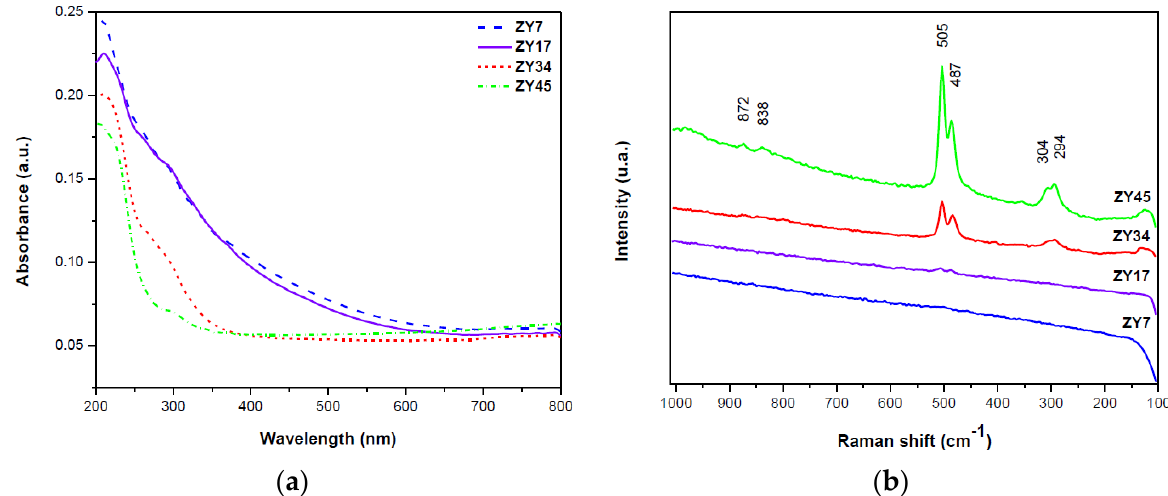
Figure 2. ( a ) UV ‒ vis and ( b ) Raman spectra of the Y ‒ type zeolites. The Raman spectra of the Y-type zeolites are presented in Figure 2b. The zeolite with a Si/Al atomic ratio of 7 did not show bands, while the sample ZY17 displayed barely noticeable bands at 505 cm − 1 and 487 cm − 1 . Both bands were intense for the ZY34 and ZY45 zeolites, and further bands at 872 cm − 1 , 838 cm − 1 , 304 cm − 1 , and 294 cm − 1 were also displayed. The bands between 200 cm − 1 and 400 cm − 1 are attributed to the